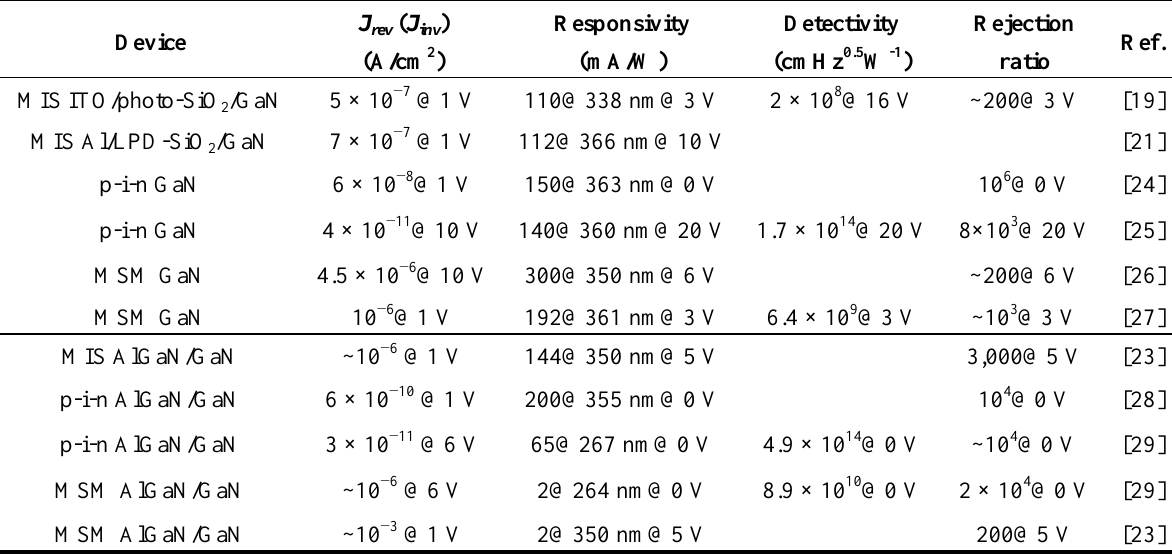
Table 1. Characteristics of III-V nitride based UV Photodetectors with different configurations. J ( J ) Responsivity rev inv Device